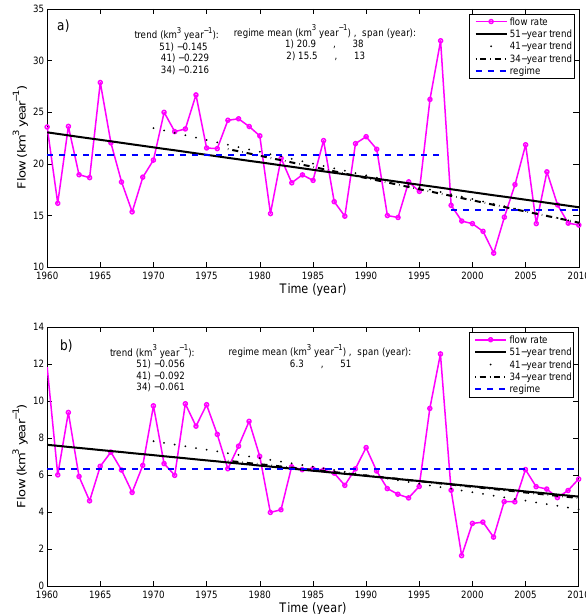
Fig. 5. Regime shifts and the detected trends for three different anal- Fig.5. Regimeshiftsandthedetectedtrendsforthreedifferentanalysisperiodsfora)theAthabascaRiveratMcMurrayandb)thegauge contributionoftheAthabascaRiverbetweentheMcMurrayandAthabascagauges. Thetrendlevelsforbothtimeseriesaresignificantand ysis periods for (a) the Athabasca River at McMurray and (b) the decreasingexceptfortheperiod1977-2010forthecontributiontimeseries. gauge contribution of the Athabasca River between the McMurray and Athabasca gauges. The trend levels for both time series are sig- nificant and decreasing, except for the period 1977–2010 for the contribution time series.